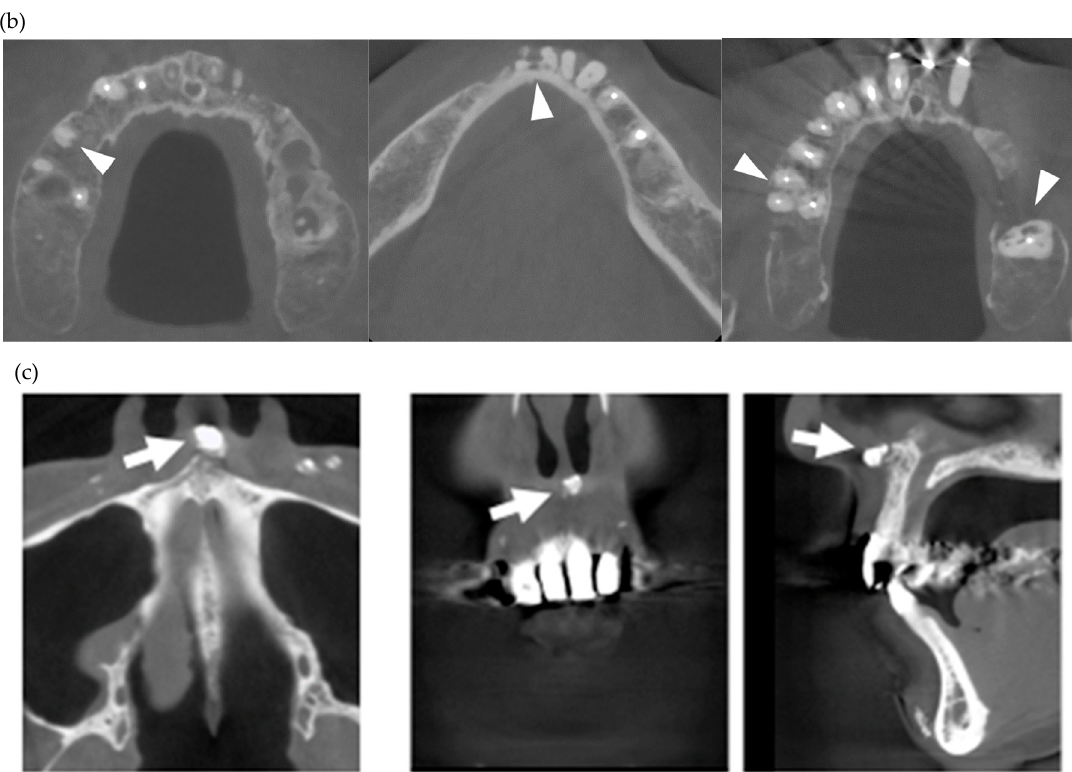
Figure 1. Multiple external root resorption and calcinosis at the oral region in pt. 2. A dental X-ray photo and cone beam computed tomography (CBCT) image of teeth ( a , b ) and the deposition of calcinosis at the nasal spur ( c ). The white arrowhead indicates root resorption, black arrowhead shows periodontal ligament (PDL) space widening and the white arrow, calcinosis.